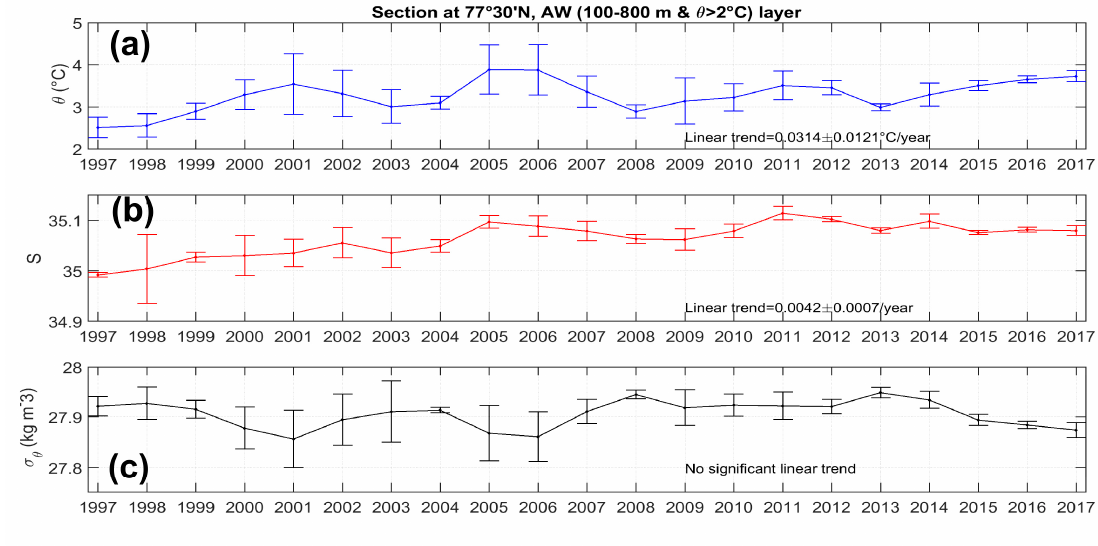
Table 1. Linear trends of θ , S and σ θ in the intermediate (100–800 m) and deep (>800 m) layers from CTD casts collected along section S (see Figures 1 and 3). Data cover the period from 1997 until 2017. Significant linear trends (p < 0.05) are reported in red.